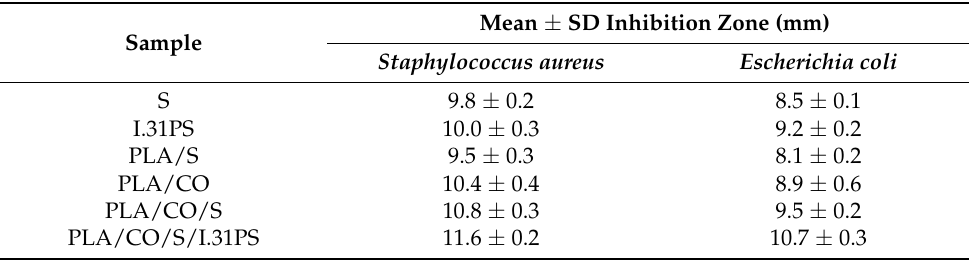
Table 1. Antibacterial activity of the developed biocomposites against S. aureus and E. coli